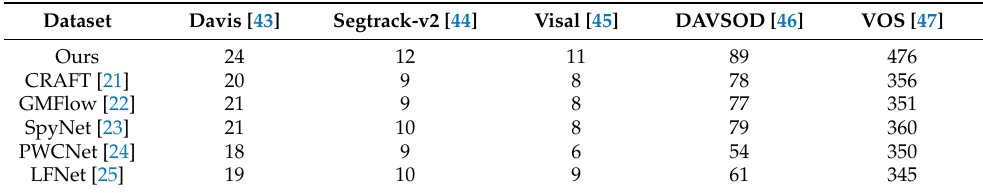
Table 4. The total memory space usage taken by different optical flow models to generate optical flow for different datasets, with the memory space unit in megabytes, “Ours” represents the optical flow model proposed in this